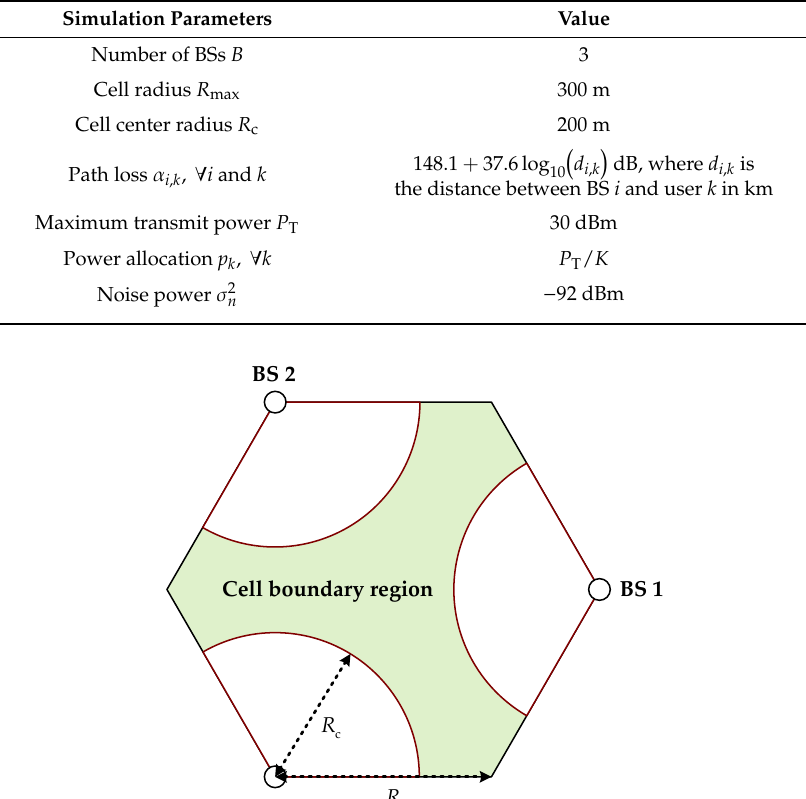
Table 2. Simulation parameters.